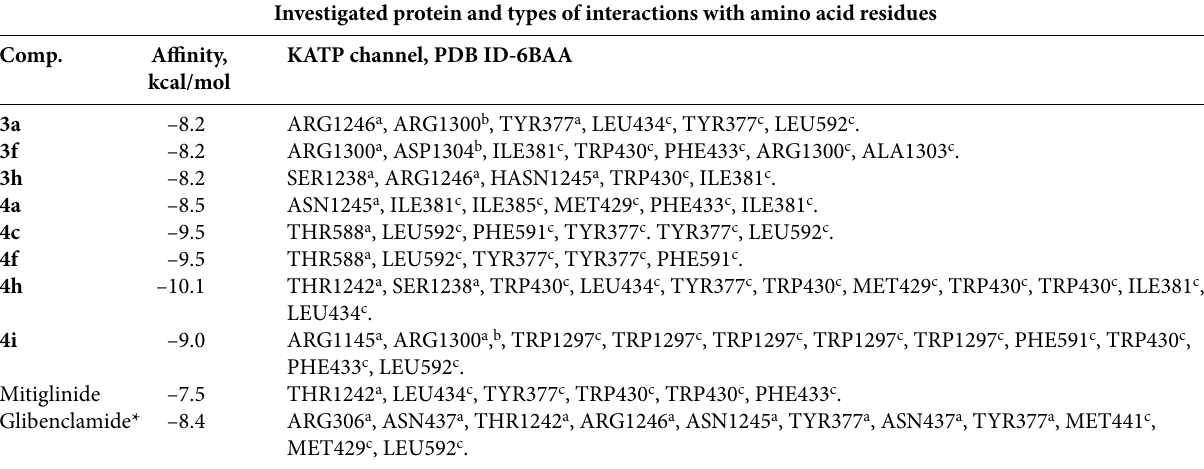
Table 2 Types of investigated compounds’ interactions with amino acid residues of the target active center according to the docking studies Investigated protein and types of interactions with аmino acid residues